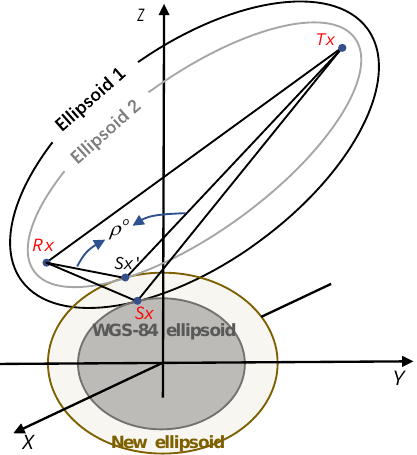
Figure 1. Schematic diagram of the ellipsoid-based geometry computation method. The transmitter ( T x ), specular point ( S x ) on WGS84 ellipsoid, and receiver ( R x ) are in the same plane, S x (cid:48) is the specular point corresponding to the path range of reflected signal ρ o , with a height of h on the new ellipsoid considering the curvature of the Earth.